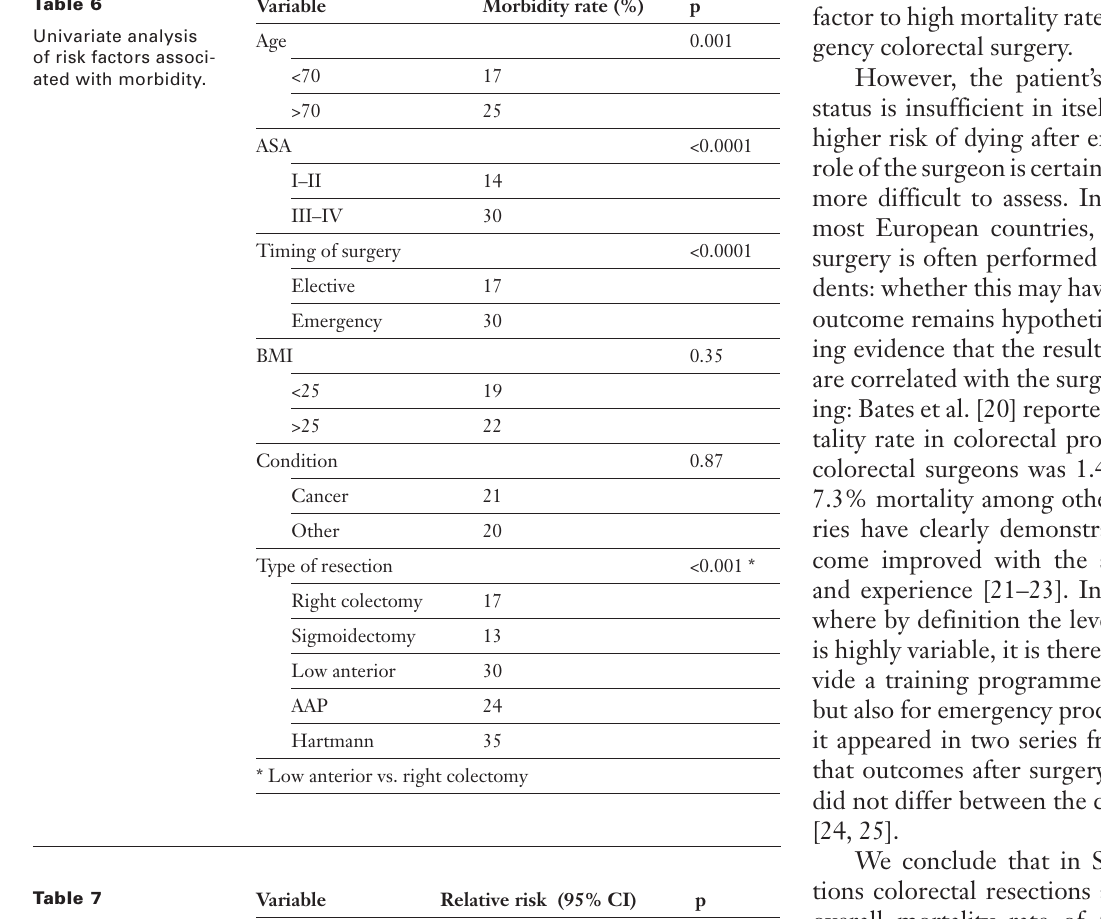
Univariate analysis of risk factors associ- ated with morbidity.